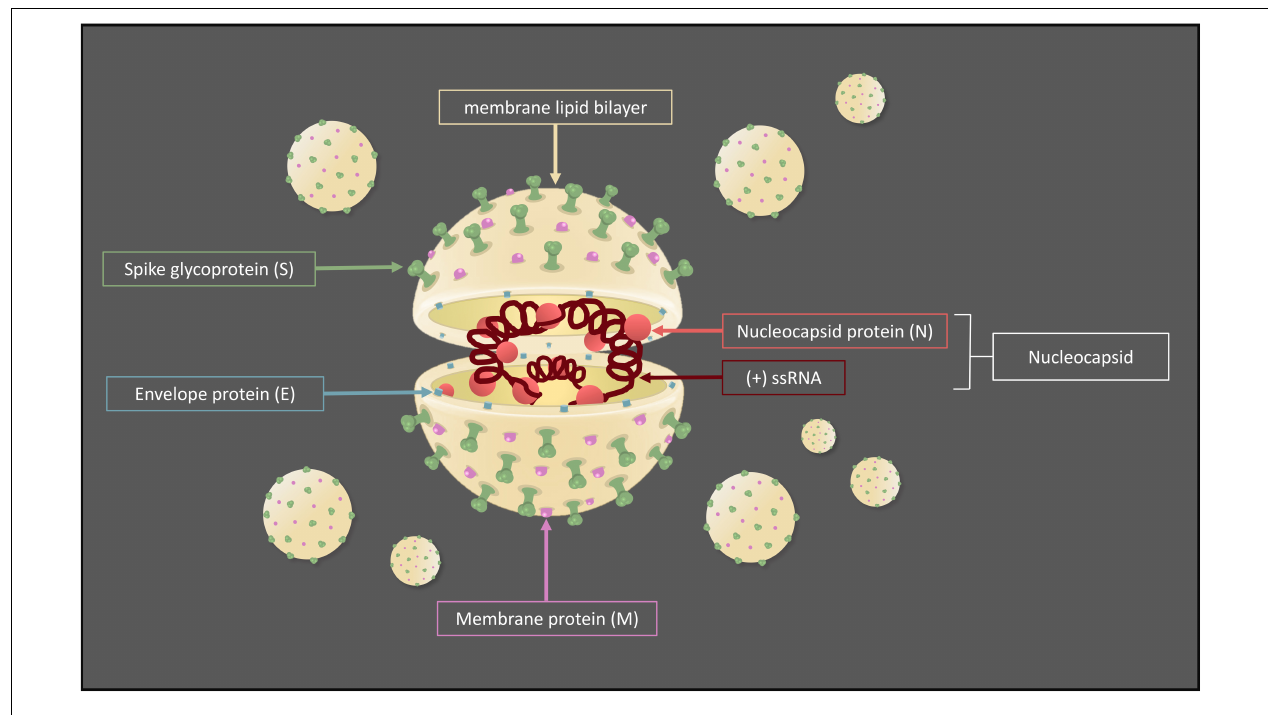
FIGURE 1 | Typical coronavirus structure.